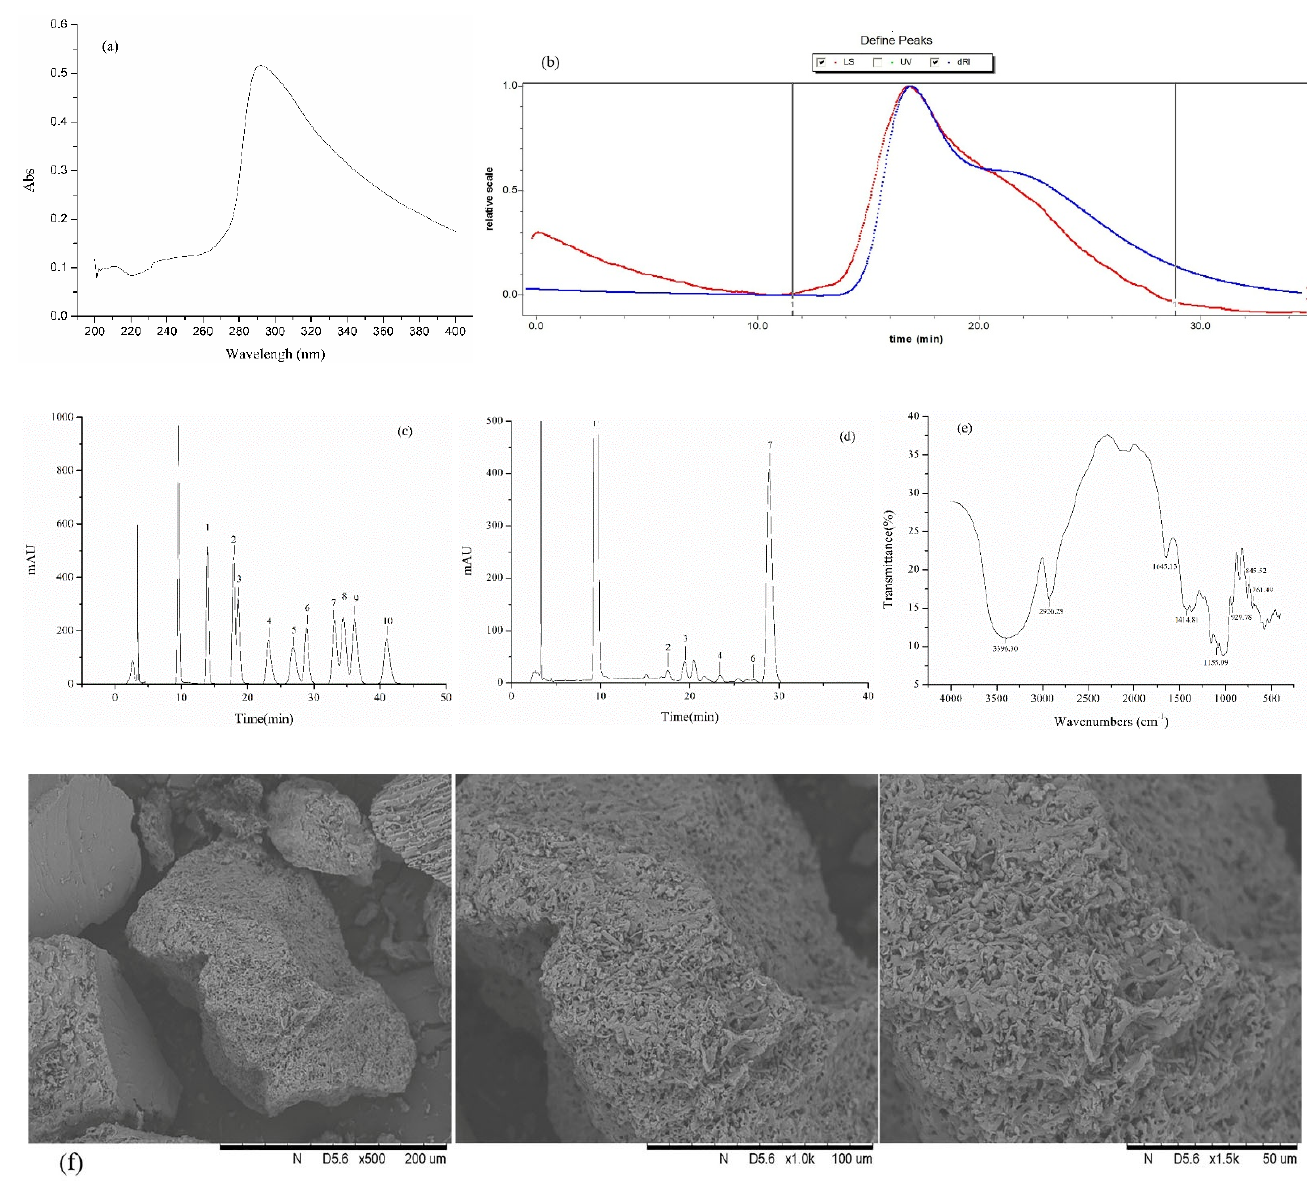
Figure 1. Preliminary characterization of IOP. ( a ) UV–Vis analysis of IOP. ( b ) Molecular weight of IOP. ( c ) The standard monosaccharide. ( d ) The monosaccharide composition of IOP. 1. D—mannose, 2. D—ribose, 3. L—rhamnose, 4. D—glucuronic acid, 6. D—galacturonic acid, 7. D—glucose, 8. D—galactose, 10. D—xylose, 11. L—Arabinose, 12. L—fucose. ( e ) FTIR analysis of IOP. ( f ) The SEM images of IOP observed at magnifications of 500×, 1000×, and 1500×.